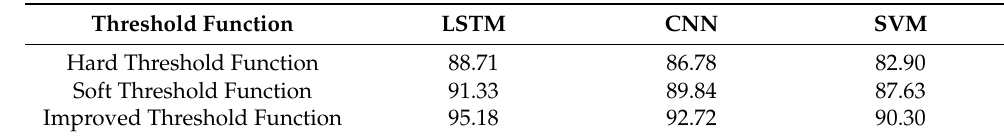
Table 5. Compare fatigue classification accuracy (in %) based on the combination of denoising threshold function and classification